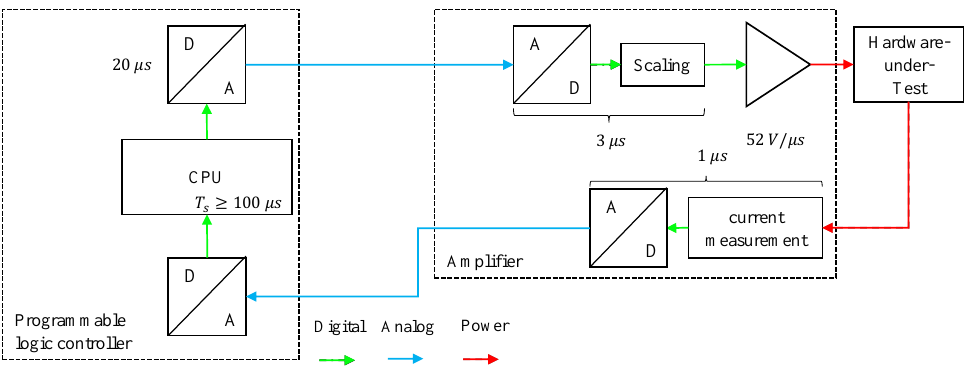
Figure 4. PHiL with analog communication between the PLC and the amplifier.